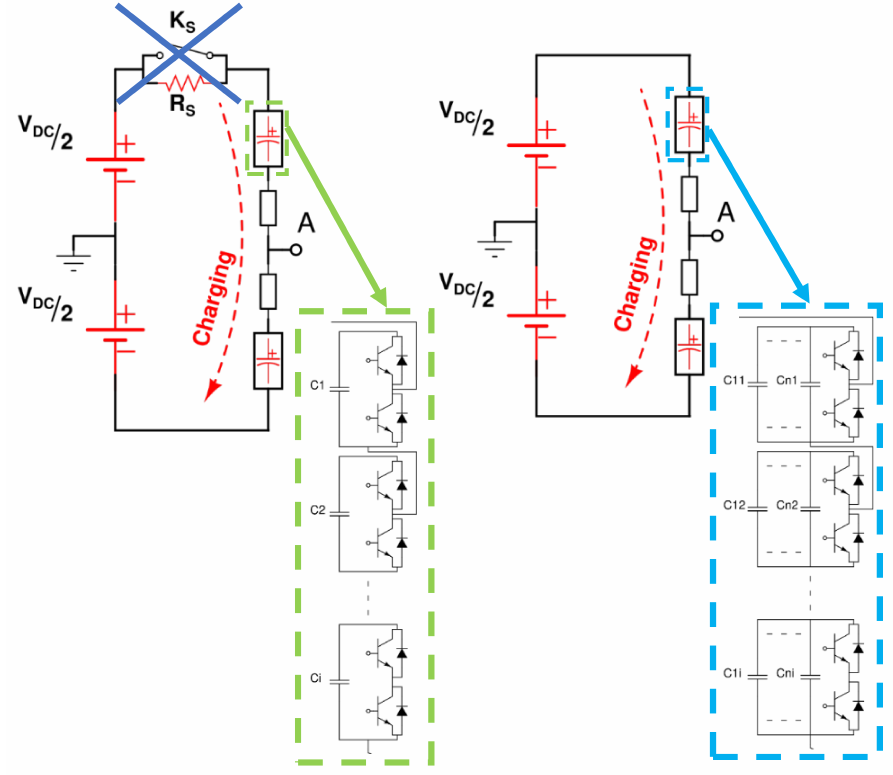
Figure 1. The first—uncontrollable—phase of the proposed start-up process